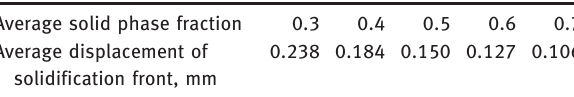
Table 4: Average displacement of solidification front in different solid phase fraction zone.